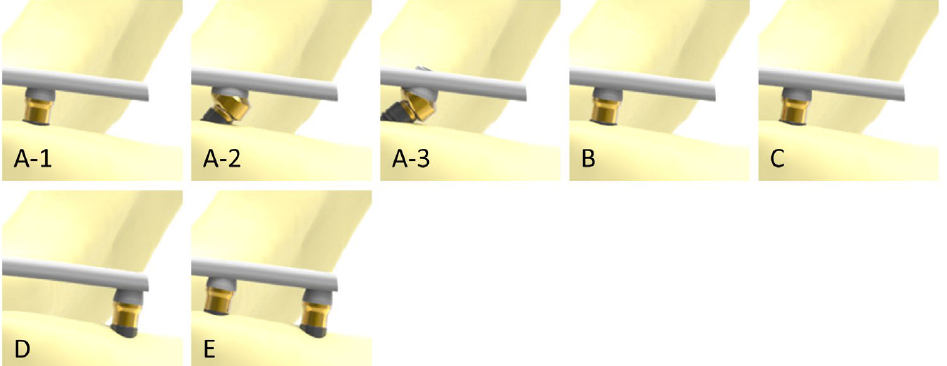
Figure 2. Above—details of the cantilevers in scenarios A-1, A-2, A-3, B, and C. Below—scenarios D and E without cantilevers.